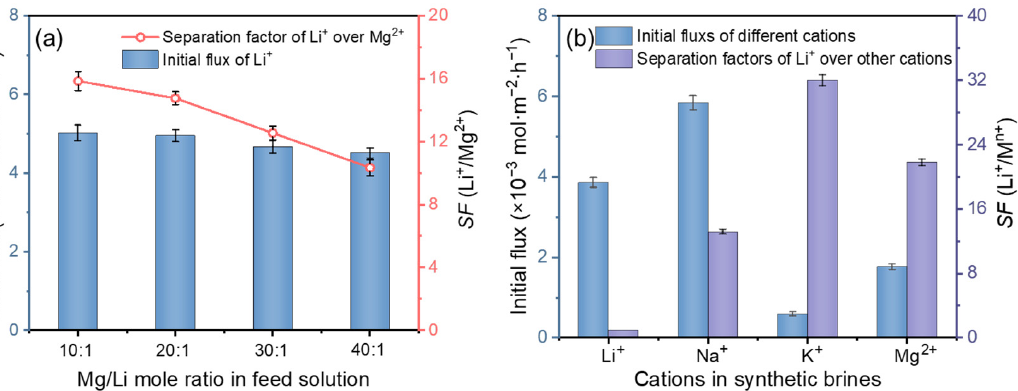
Figure 8. ( a ) Effect of Mg/Li mole ratio (feed solution: 0.1 mol/L LiCl, 1.0/2.0/3.0/4.0 mol/L MgCl 2 , 0.13 mol/L FeCl 3 ); ( b ) Li + separation performance from synthetic brines (feed solution: 0.1 mol/L LiCl, 2.0 mol/L NaCl, 0.5 mol/L KCl, 1.0 mol/L MgCl 2 , 0.13 mol/L FeCl 3 ). Membrane: CTA/P507-TBP60%; test time: 24 h; n = 5.